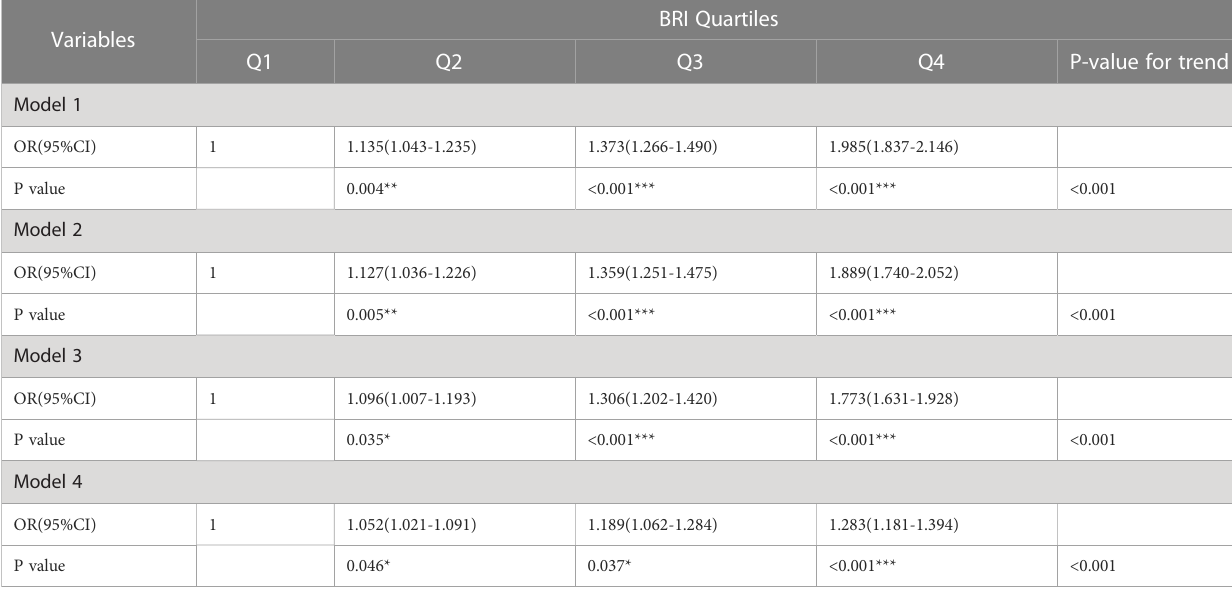
TABLE 2 Association between BRI quartiles and eGFR in the total population.